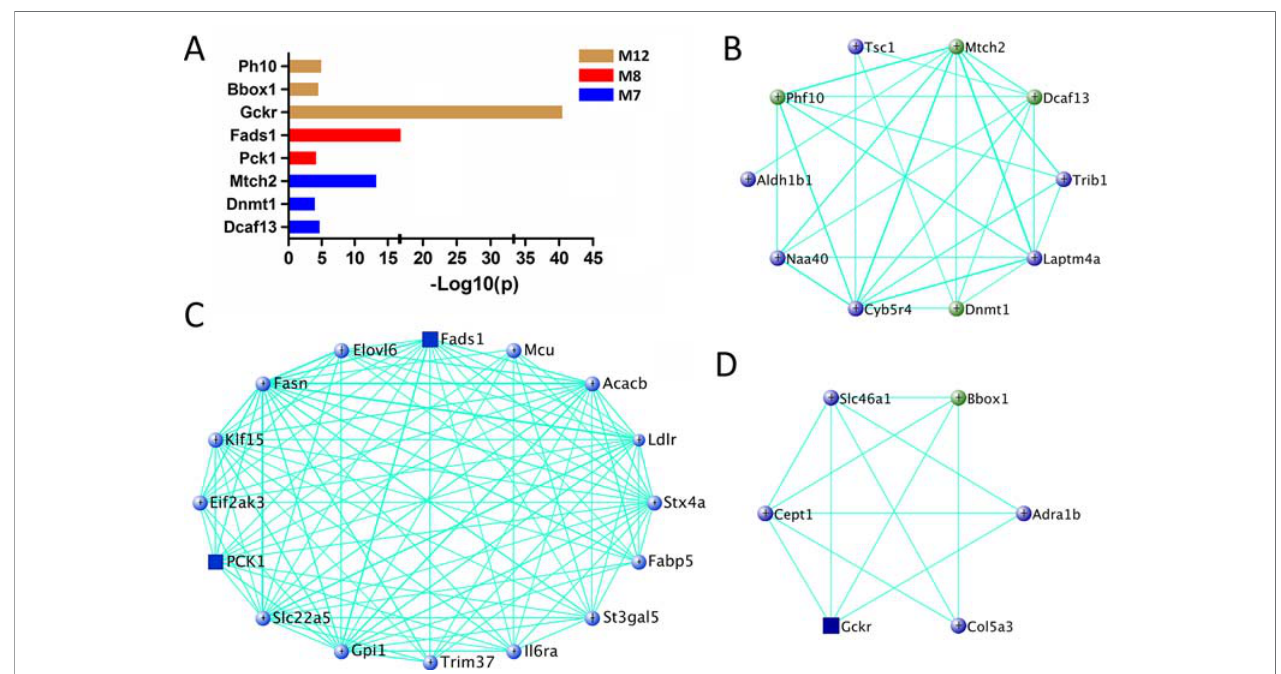
FIGURE 6 | Gene prioritization for fasting glucose-associated modules. (A) Human GWAS overlapping genes for fasting glucose-associated modules. Genes with GWAS p value <1 × 10 − 4 of fasting glucose level were retrieved from GRASP and GWAS Catalog. (B – D) Gene subnetworks for module M7, M8, and M12. The coloring scheme is same as Figure 4C